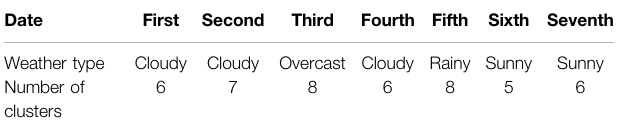
TABLE 1 | Number of clusters per day.